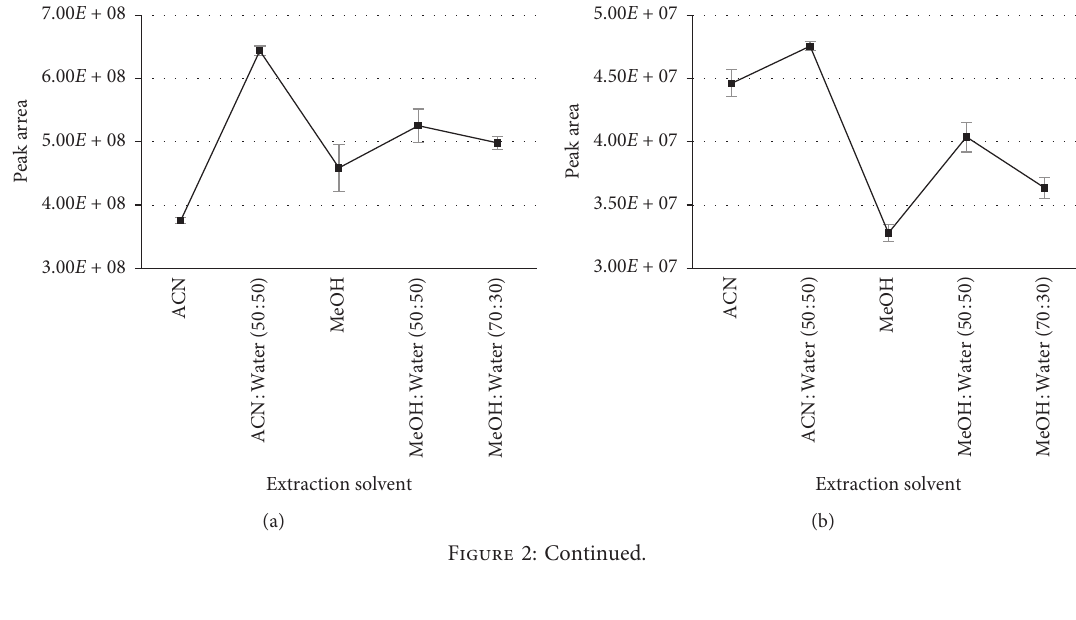
Figure 1: Screening workflow for unknown substances.